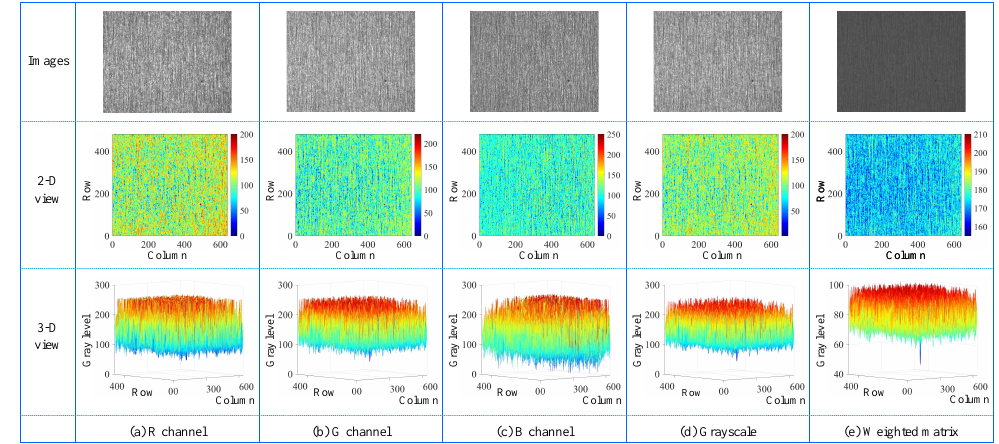
Figure 3. The first column shows R channel, G channel, B channel, grayscale version, and weighted matrix of a steel surface image, respectively, while the second and third columns present their corresponding 2D and 3D views. The weighted matrix is derived from the weighted summation of the R, G, and B